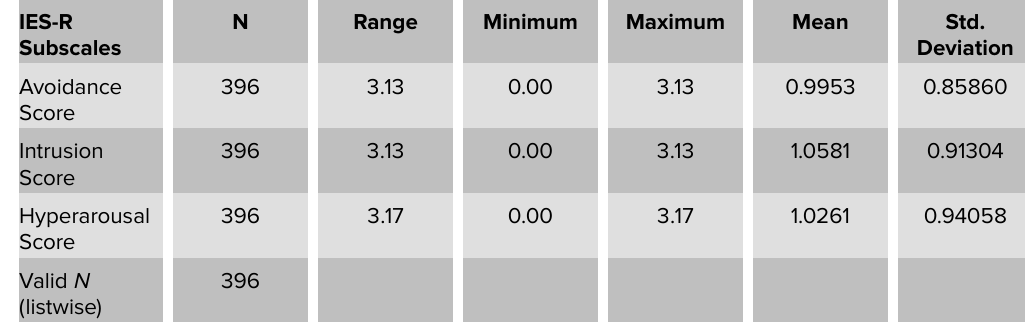
TABLE 6: Comparison of demographic characteristics and COVID-19 exposure and perception with